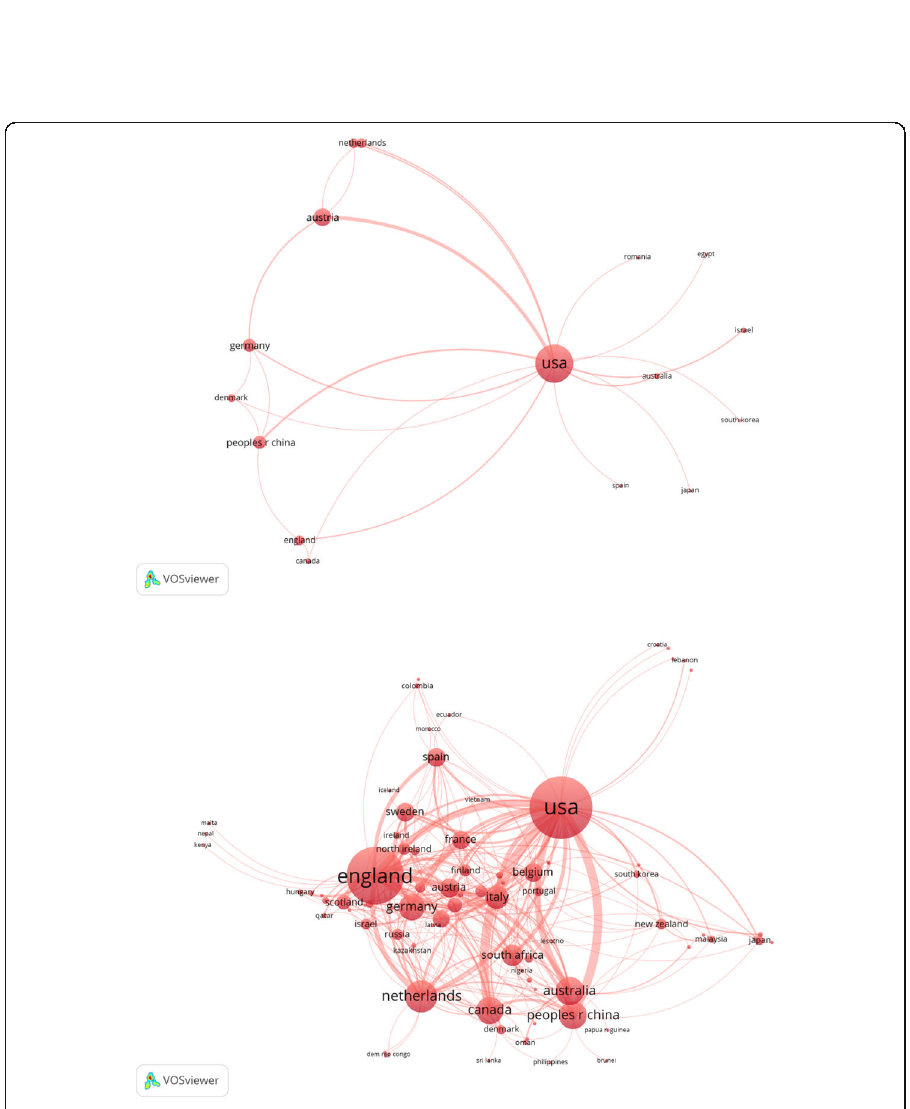
Fig. 6 Visualisations of cross-national co-authorship links in 1998 - top and 2018 –